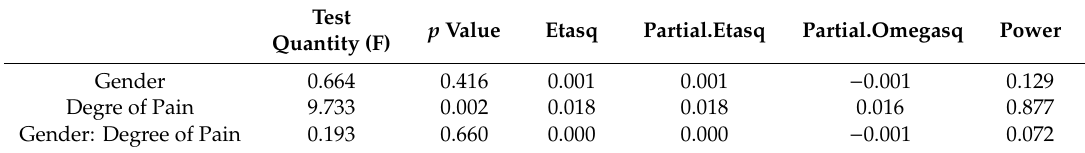
Table 5. Result of the ANOVA of the two observation groups Men / women with and without pain. Test p Value Etasq Partial.Etasq Partial.Omegasq Power Quantity (F) Gender 0.664 0.416 0.001 0.001 − 0.001 0.129 Degre of Pain 9.733 0.002 0.018 0.018 0.016 0.877 Gender: Degree of Pain 0.193